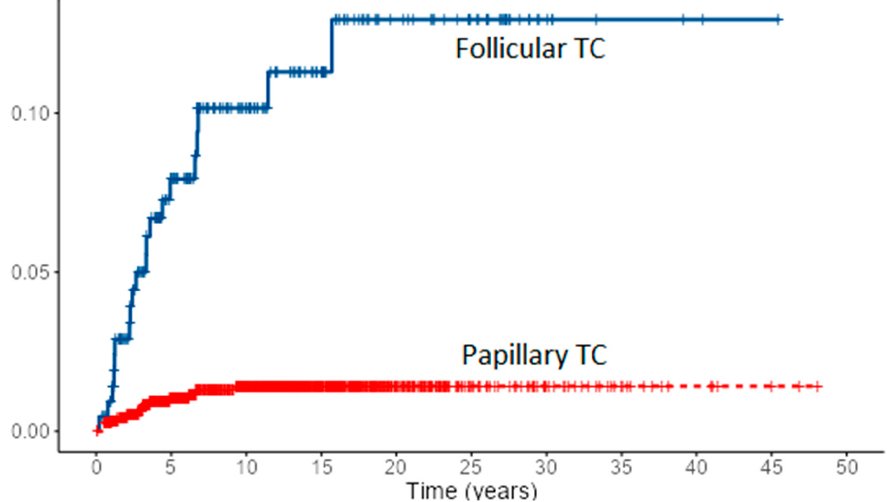
Figure 5. Cumulative death events (hazard) for PTC and FTC patients.